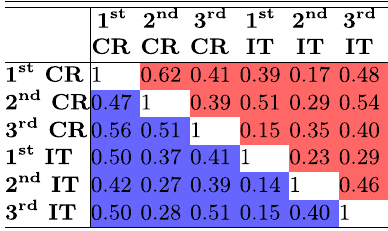
TABLE V. Correlation table for scores of CR and IT questions in the final exams. The upper triangle lists the intratest question correlation coefficients for the red final exam, and the lower triangle lists those for the blue final exam. For example, for the upper triangle the row and column labels 2nd ITeach refer to IT3, and for the bottom triangle these refer to IT4, as these are the second IT within each respective